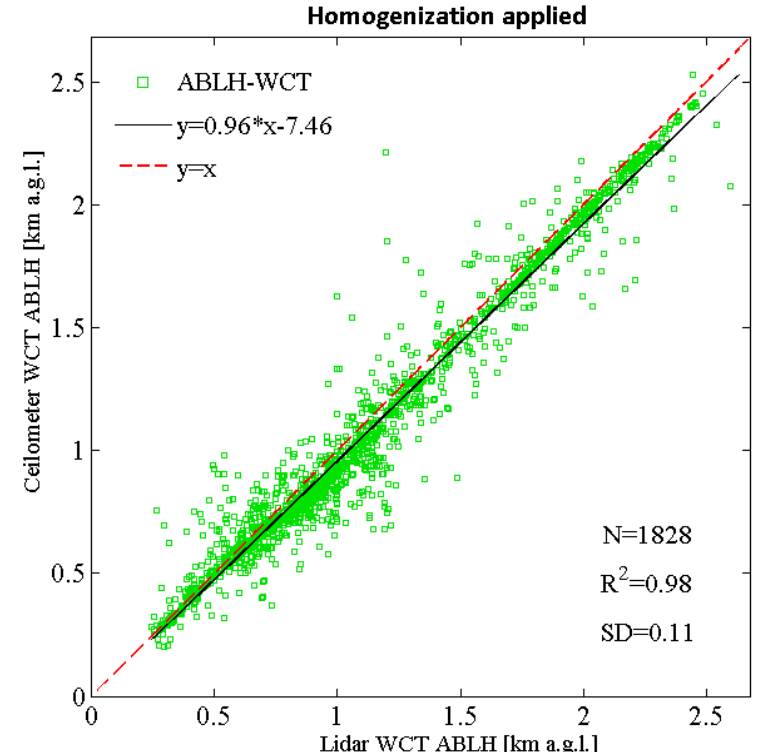
Figure 6. Correlation plots of ABLH derived from the PollyXT lidar and the CHM15k ceilometer collocated observations in Warsaw from July to October 2013. Each data point represents the 10 min average. The WCT algorithm was applied for the ABLH retrieval. The lidar-derived ABLHs’ homogenization was done using the thresholds defined in Equation (2).